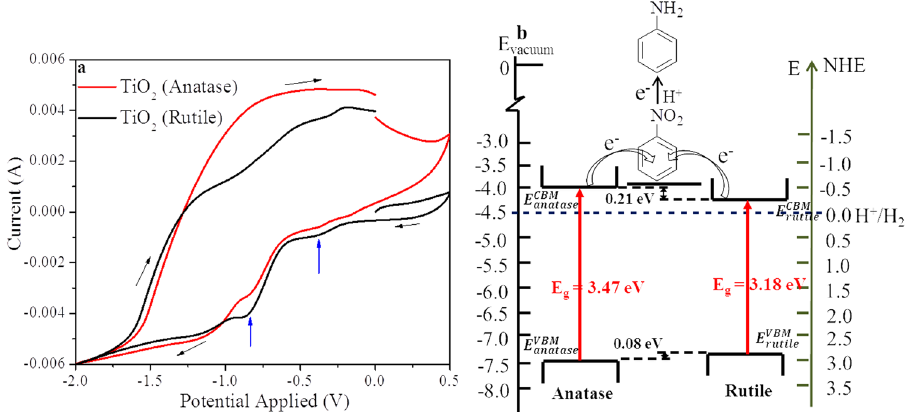
Figure 6. ( a ) Cyclic voltammetric study for electrochemical reduction of nitrobenzene over anatase, and rutile TiO 2 , and ( b ) Schematic illustration of energetics of nitrobenzene reduction over anatase, and rutile TiO 2